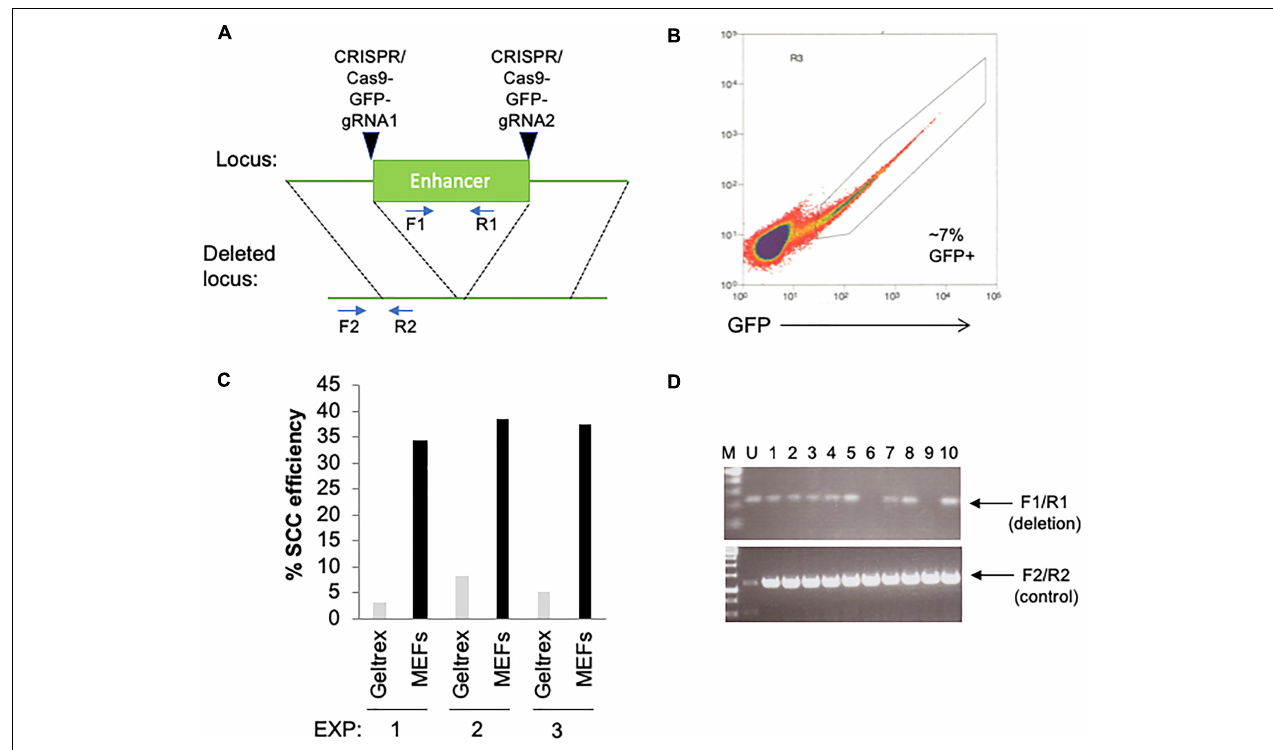
FIGURE 2 | Utilization of feeder layers are more efficient than basement membrane matrices when single-cell cloning hPSCs with RevitaCell and KSR following a transfection. (A) Diagram depicting the targeting site for each CRISPR/Cas9 GFP plasmids and predicted results following genomic deletion. Primer sequences are indicated by arrows. (B) Two days following an electroporation of the CRISPR/Cas9 plasmids, hPSCs were seeded by FACS as single-cells onto 96-well plates coated with Geltrex (1/100 dilution) or pre-seeded with MEFs (1 million cells/96-well plate) using three replicate conditions. (C) Single-cell cloning (SCC) efficiency following the FACS isolation of transfected cells. (D) Genomic screening by PCR using indicated primers to identify the deletion of the